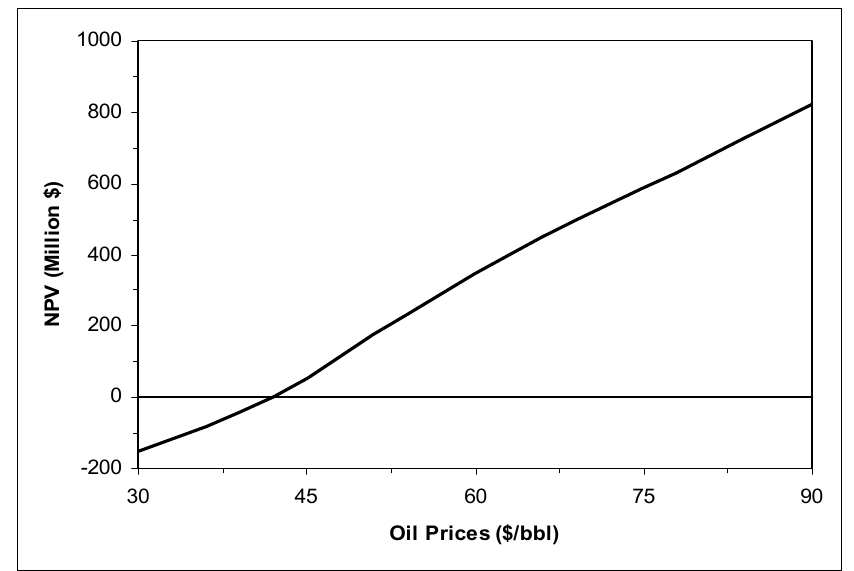
Figure 5. Variation of NPV with crude oil